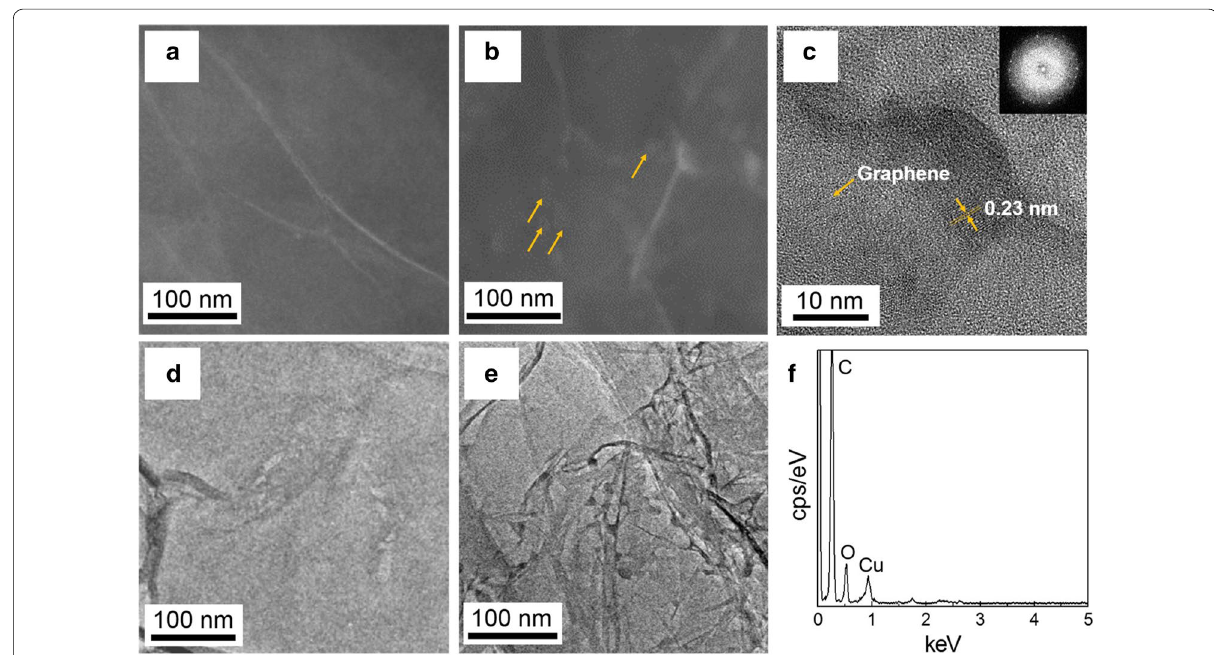
Fig. 3 a , d TEM and STEM images of GO. b , e TEM and STEM images of the CuO–GO nanocomposite catalyst. c HRTEM image of the CuO–GO nanocomposite catalyst. The inset shows the relevant FFT image. f EDX spectrum of the CuO–GO nanocomposite catalyst